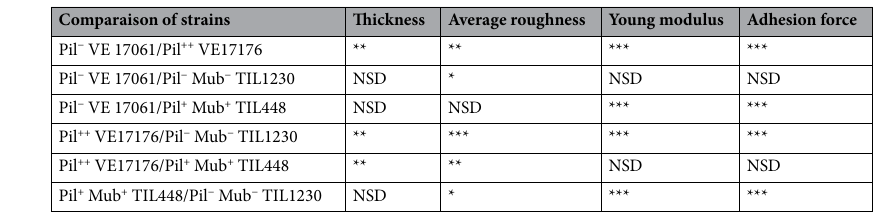
Table 3. Comparaison of the average values obtained for one strain against those obtained for another one. For this, the ANOVA test for each parameter (thickness, average roughness, Young modulus and Adhesion force) was used with threshold of 5% (*), 1% (**) and 0.1% (***). NSD: no significant